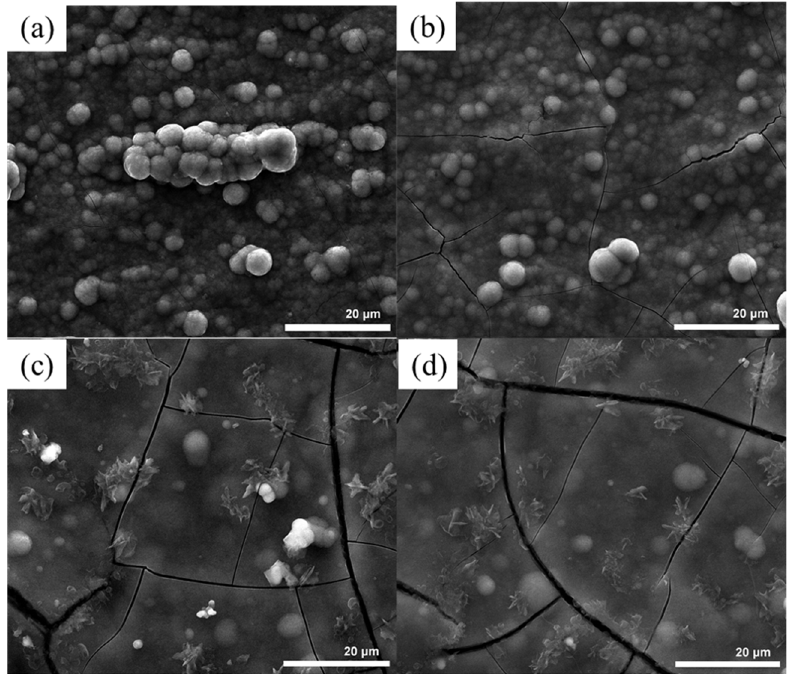
Figure 6. SEM images of the HEA films deposited for 90 min: AlCrCuFeMnNi at ( a ) − 2.5 V and ( b ) − 2.7 V; AlCrFeMnNi at ( c ) − 2.5 V and ( d ) − 2.7 V [19].